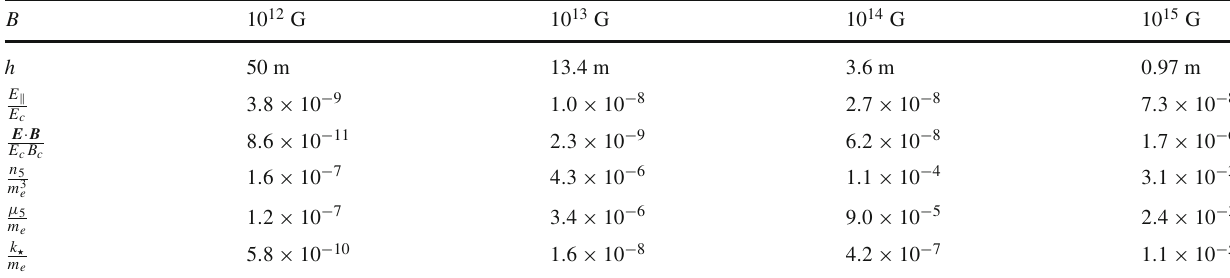
Table 1 Estimated values of the model parameters and the chiral characteristics in the gap regions of the pulsar magnetospheres